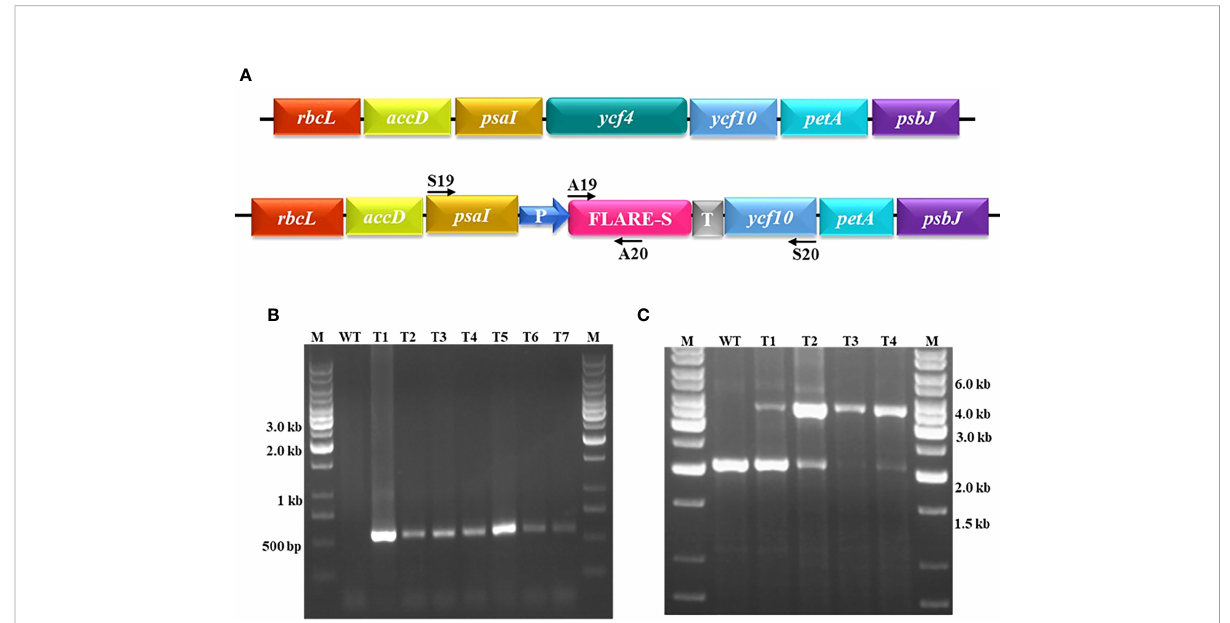
FIGURE 2 Con fi rmation of transgene integration into plastid genome and determining the plasmy level by Polymerase Chain Reaction. (A) Physical map showing the positions of the primers used. (B) Entire pool of spectinomycin-resistant plants regenerated on regeneration medium were screened for the presence of marker gene aadA-speci fi c primer set (A19/A20): M is 1 kb marker DNA, WT is the untransformed tobacco, and T1-T7 are putative transplastomic plants. (C) Out of screened plants four as T1-T4 were randomly selected for the determination of plasmy level using S19/S20 primer set that lands on fl anking sequences: M represents 1.0 kb DNA ladder, WT represents wild-type tobacco plant whereas T1-T4 represents deletion level of ycf4 from the chloroplast transgenic plants regenerated on spectinomycin-containing regeneration medium. Ampli fi cation of a fragment of 4.0 kb indicates transgene integration whereas ampli fi cation of a fragment of 2.0 kb represents wild-type plastid DNA.